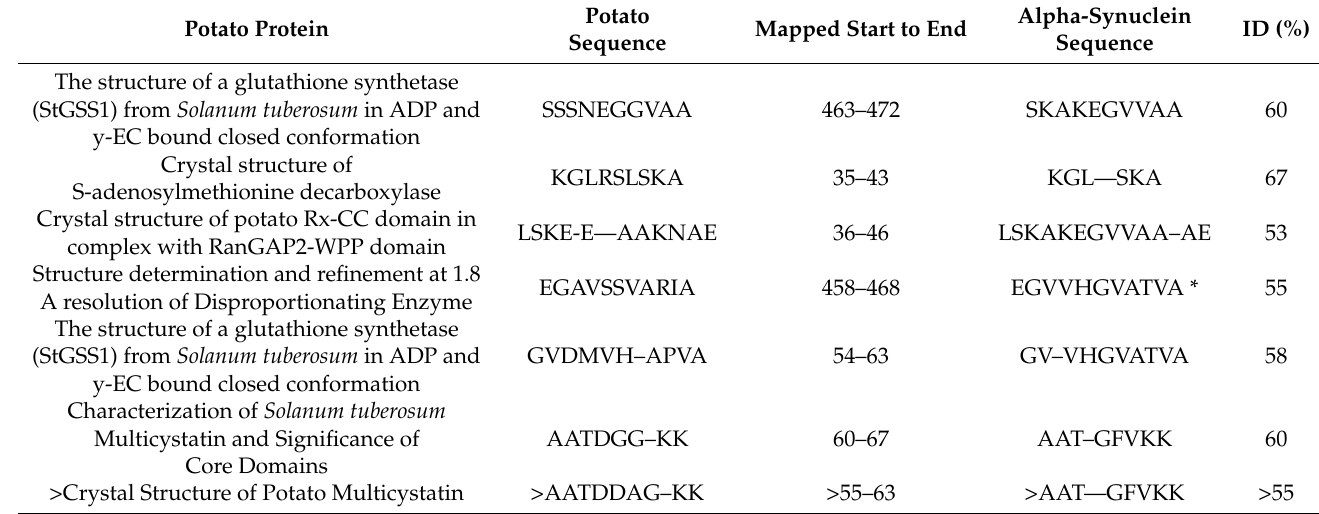
Table 6. Potential cross-reactive epitopes between alpha-synuclein proteins and potato proteins. Potato